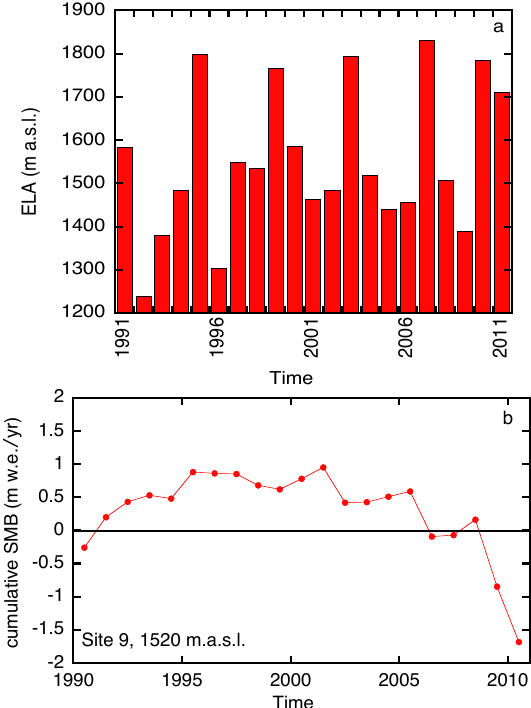
Figure 5. (a) Equilibrium line altitude as a function of time and (b) Cumulative surface mass balance near the equilibrium line indicating an extension of the ablation zone over the last few years.